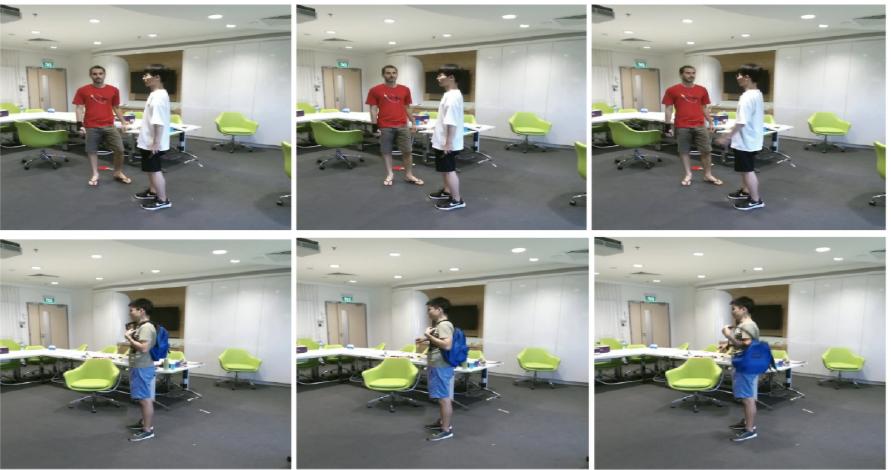
Figure 6. Samples from NTU-RGB+D 120 dataset. Top: A115—take a photo; Bottom: A88—take off